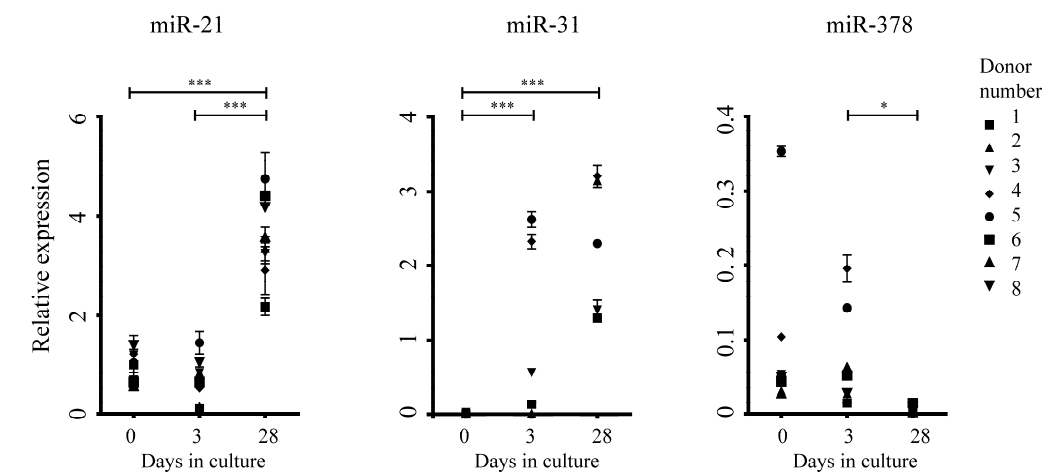
Figure 2. Quantitative RT-PCR validates microarray results. qRT-PCR was used to validate a subset of the microarray data (target microRNAs miR-21, miR-31, and miR-378 as indicated) in eight subsequent donors (D1–D8). Error bars represent technical repetitions. * denotes p value < 0.05, *** denotes p value <